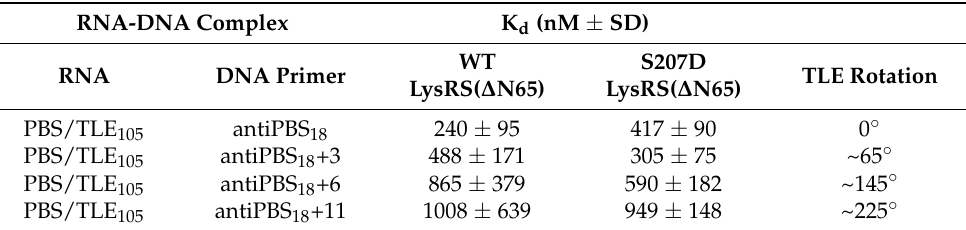
values are approximated by orienting the SAXS envelopes as shown in Figure 5C and drawing a line from the A-bulge to the TLE loop regions of the envelopes. The lines were then compared to reflect the approximate counterclockwise